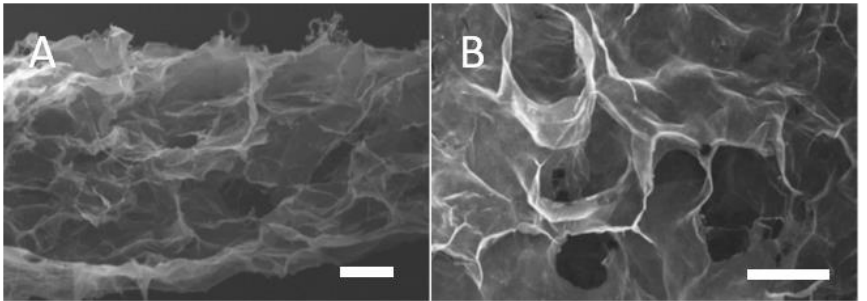
Figure 3. SEM images of lyophilised collagen-GMA hydrogel: ( A ) Lyophilisation formed a sponge- like collagen-GMA hydrogel that was hundreds of microns thick; ( B ) Pore structure was around 100 μm in diameter. Scale bar is 100 μm.